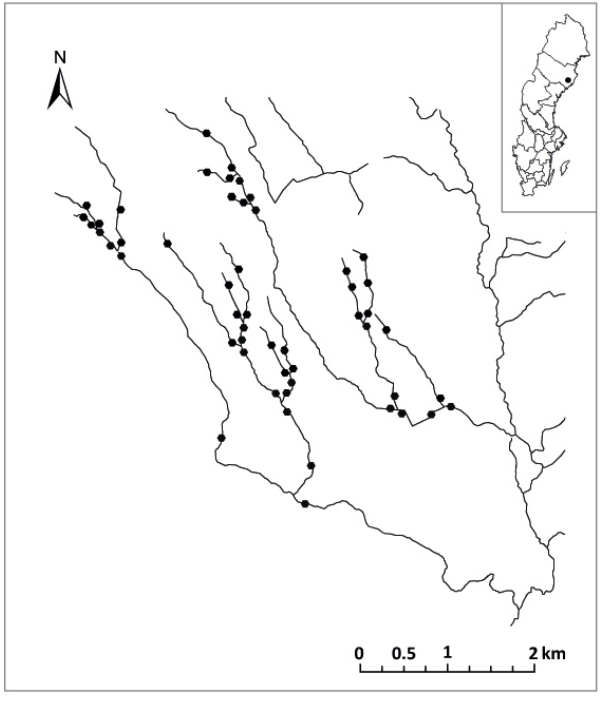
Fig. 1 . Location of the Krycklan catchment in Sweden (top right) and location of the 52 sampling sites within the